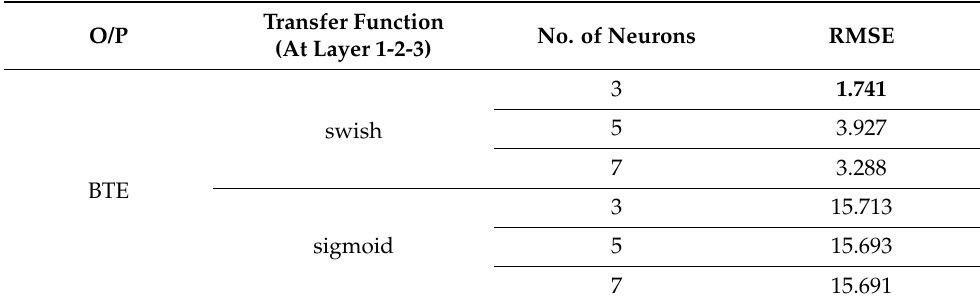
Table 5. RMSE value for BTE, CO, HC, NO x , and Smoke computed using swish and sigmoid activation function taking number of neurons as 3, 5 and 7 at hidden layer of the ANN model.